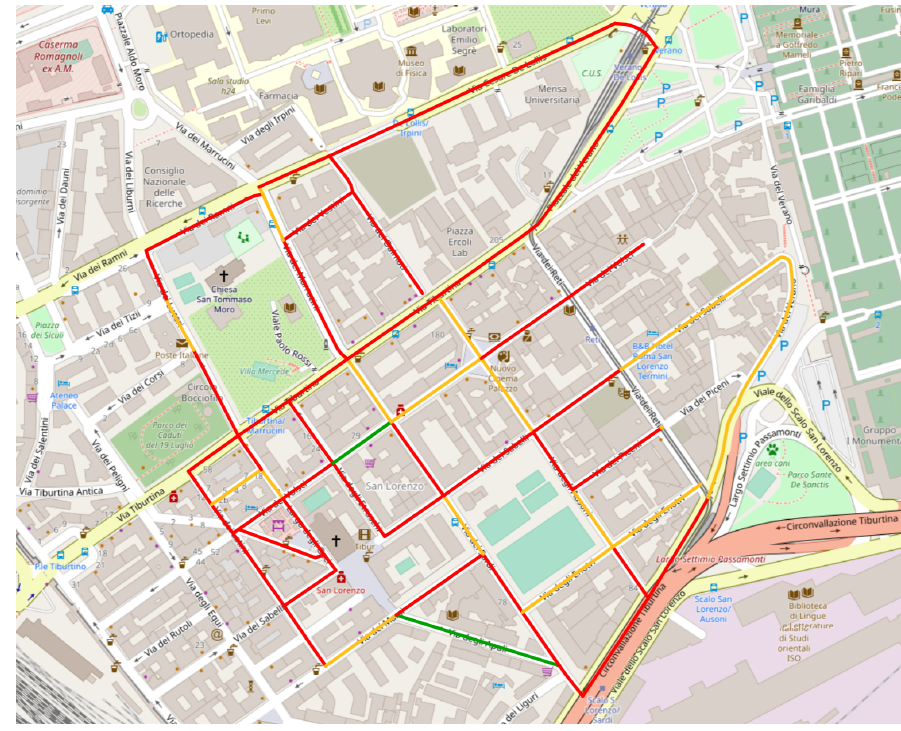
Figure 10. San Lorenzo ground truth Parking